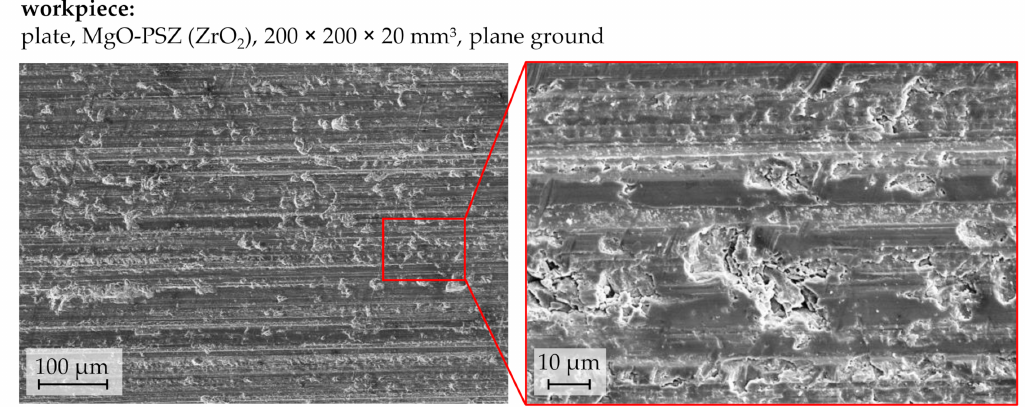
Figure 4. SEM images of the plane ground ZrO 2